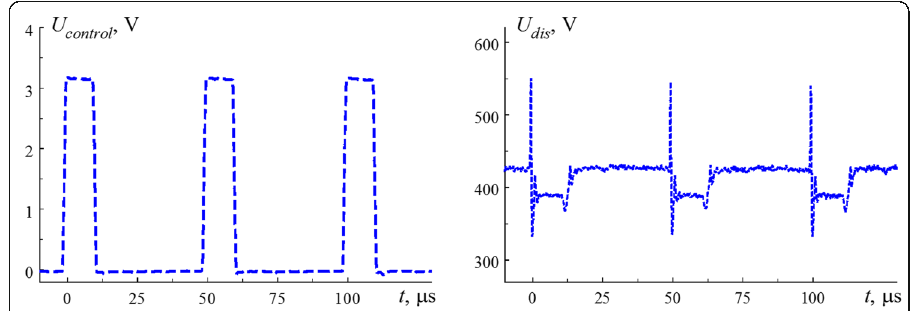
Fig. 3 Oscillograms of control signals (left) and voltage drop (right) at the sources during the